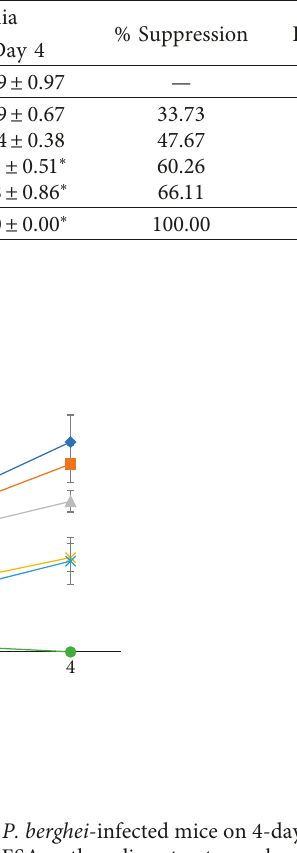
Table 2: In vivo suppressive activity of ethanolic leaf extract of S. androgynus (4-day suppressive test) against P. berghei -infected mice. Drug/Extract